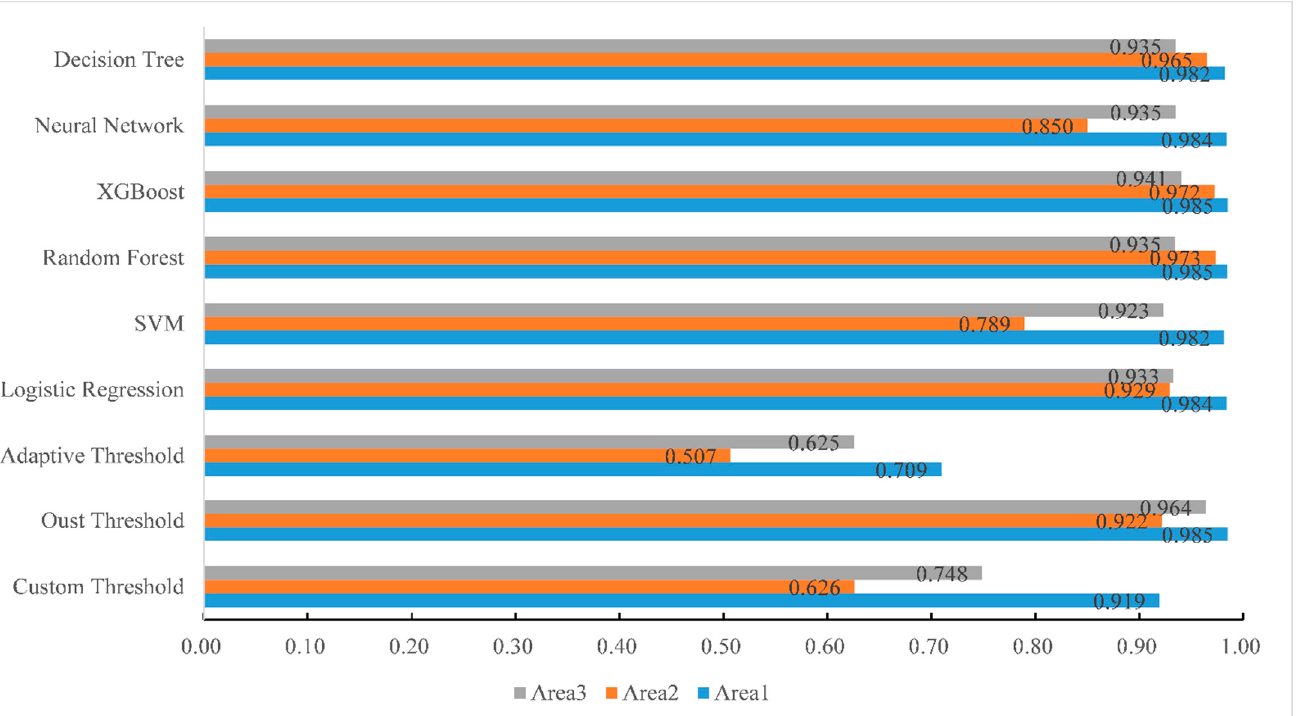
Figure 3. Statistics of the AUC index of each algorithm applied in the three regions.